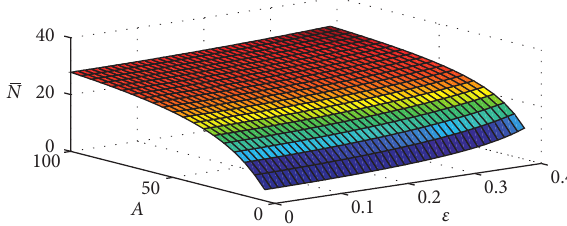
Figure 12: A plot of the mean number of photon pairs (equation (35)) versus ε and A for η � 0 . 1, κ � 0 . 8, and n th � 0 . 15.